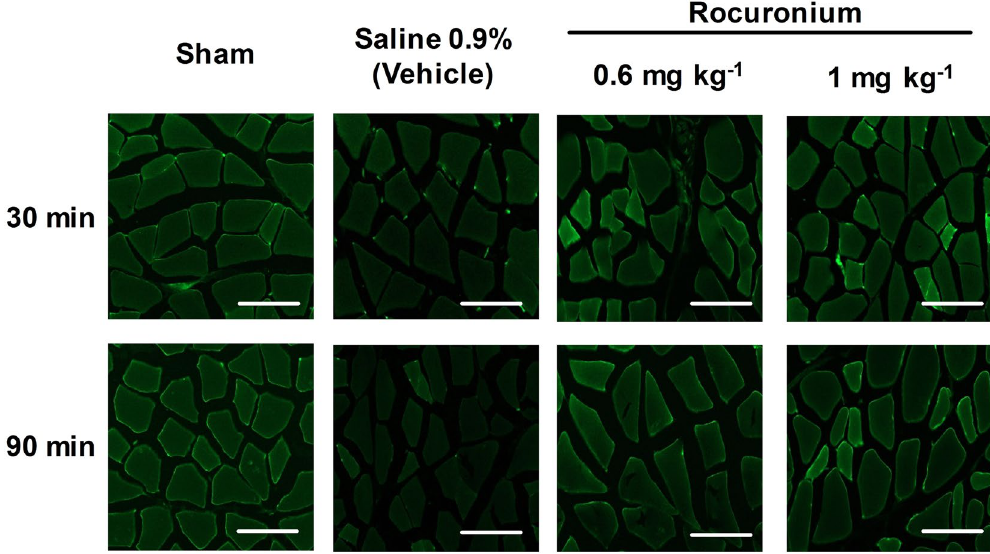
Figure 3. Exemplary immunoreactivity of Dystrophin (Dys) in the gracilis muscle 30 and 90 min after induction of ischaemia in animals receiving saline 0.9% (vehicle) vs. rocuronium 0.6 mg kg − 1 or 1 mg kg − 1 , respectively. Weaker green fluorescence indicates increased disintegration of the cell membrane. Scale bar represents 50 µ